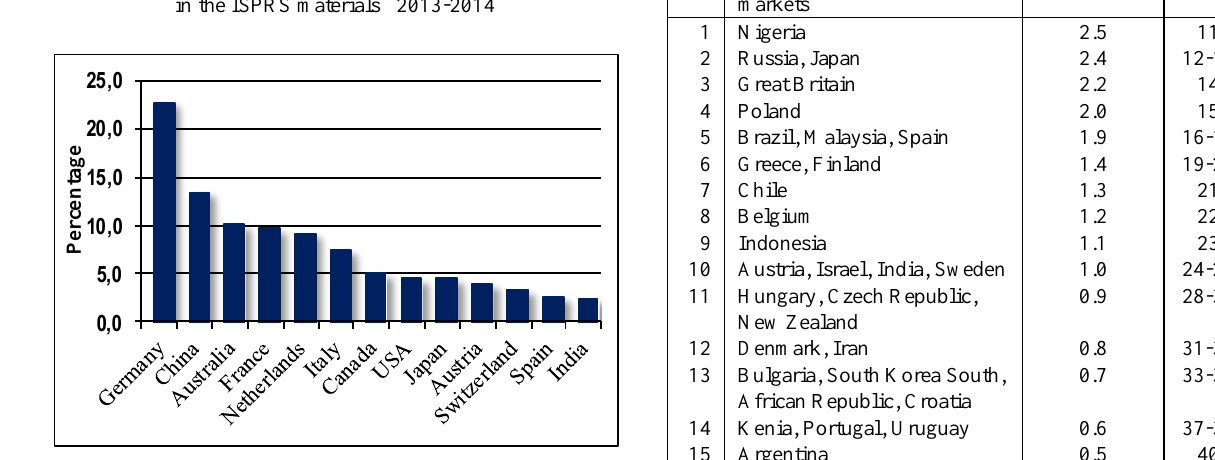
Figure 16. Countries that presented largest number of papers and reports at ISPRS scientific events in 2012-2014